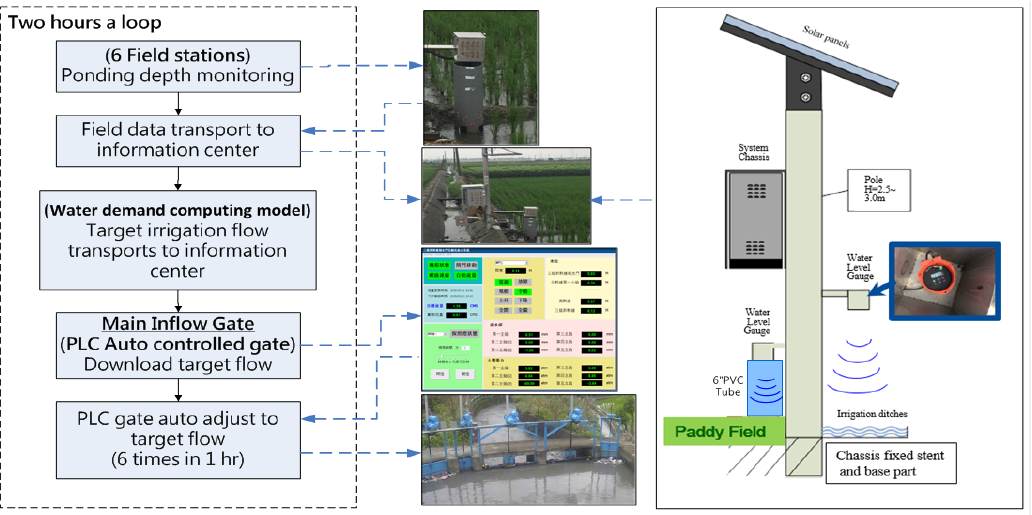
Figure 2. Smart irrigation system equipped with water level sensors and control unit [1].